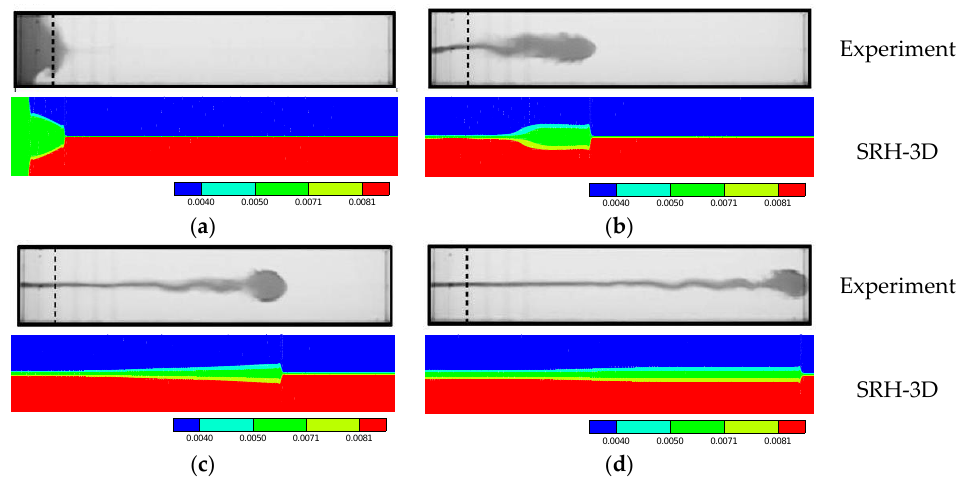
Figure 11. Temporal evolution of the SFTC intrusive gravity current—sediment concentration contours. Experiment is from [52] and visualized by adding dye. ( a ) Time = 2 s; ( b ) Time = 14 s; ( c ) Time = 26 s; ( d ) Time = 38 s.